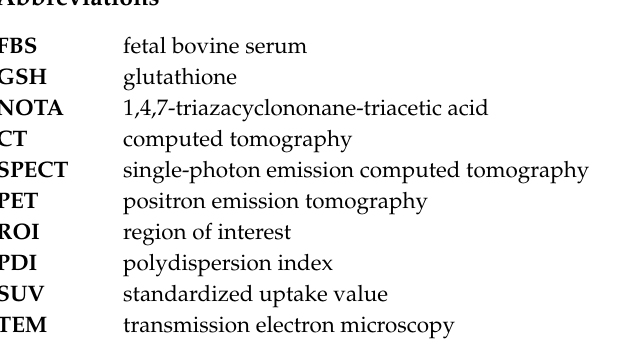
Figure S1: Thin layer chromatography of 64Cu. Figure S2: 64Cu images in the lymphatic route. Figure S3: 68Ga-labeled exosomes in the lymphatic route. Figure S4: Free-64Cu images in the hematogenous route. Figure S5: 68Ga-labeled exosomes in the hematogenous route. Table S1: Hydrodynamic size, PDI (polydispersion index), and zeta potential of exosomes according to the labeling